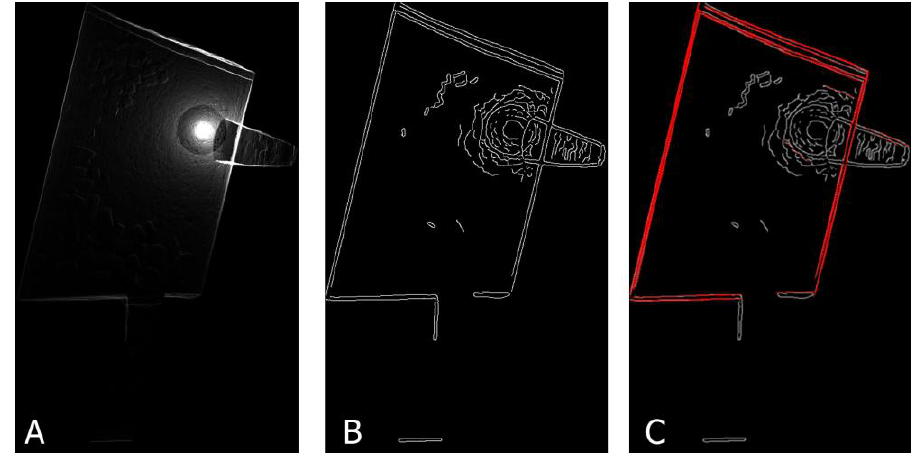
Fig 4. Stages of determination of possible vertical planes: (a) 2D histogram of the number of 3D points, (b) edges detected with the Canny algorithm, (c) approximation of edges by sections of straight